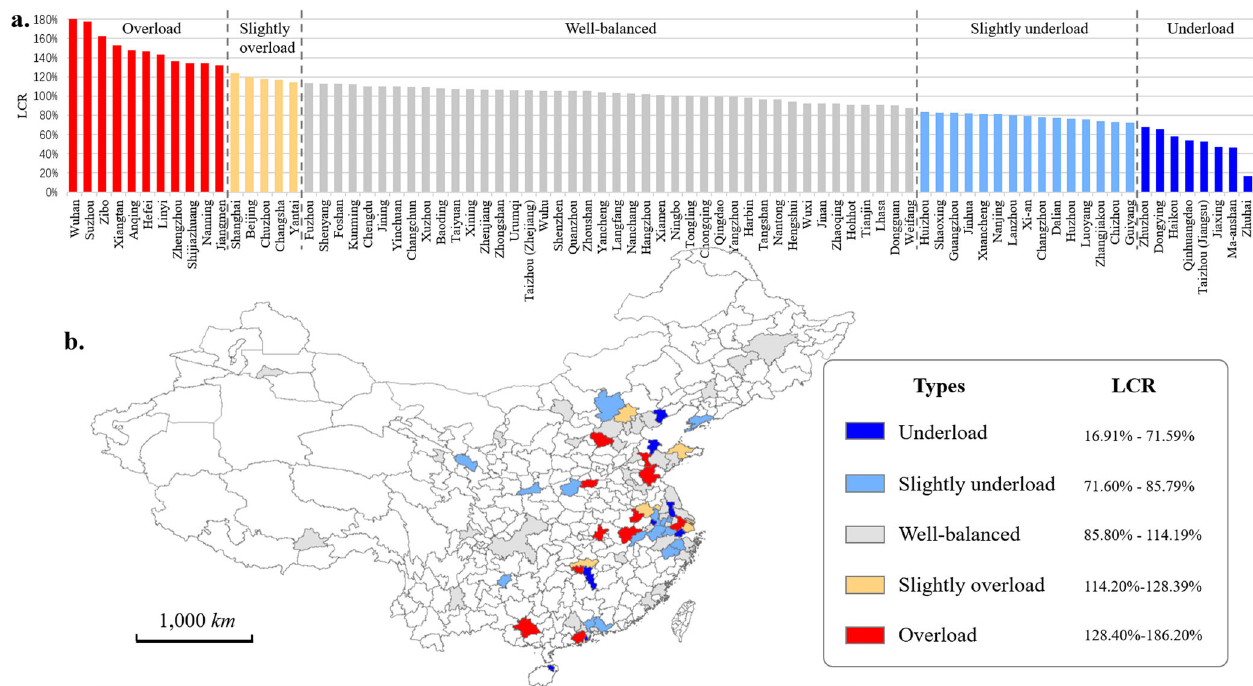
Fig. 5 Cities classi fi ed into fi ve types in reference to land carrying rate (LCR), i.e., underload, slightly underload, well-balanced, slightly overload, and overload. a Cities ’ LCR which are ranked in descending order. b Spatial distributions of the fi ve types of